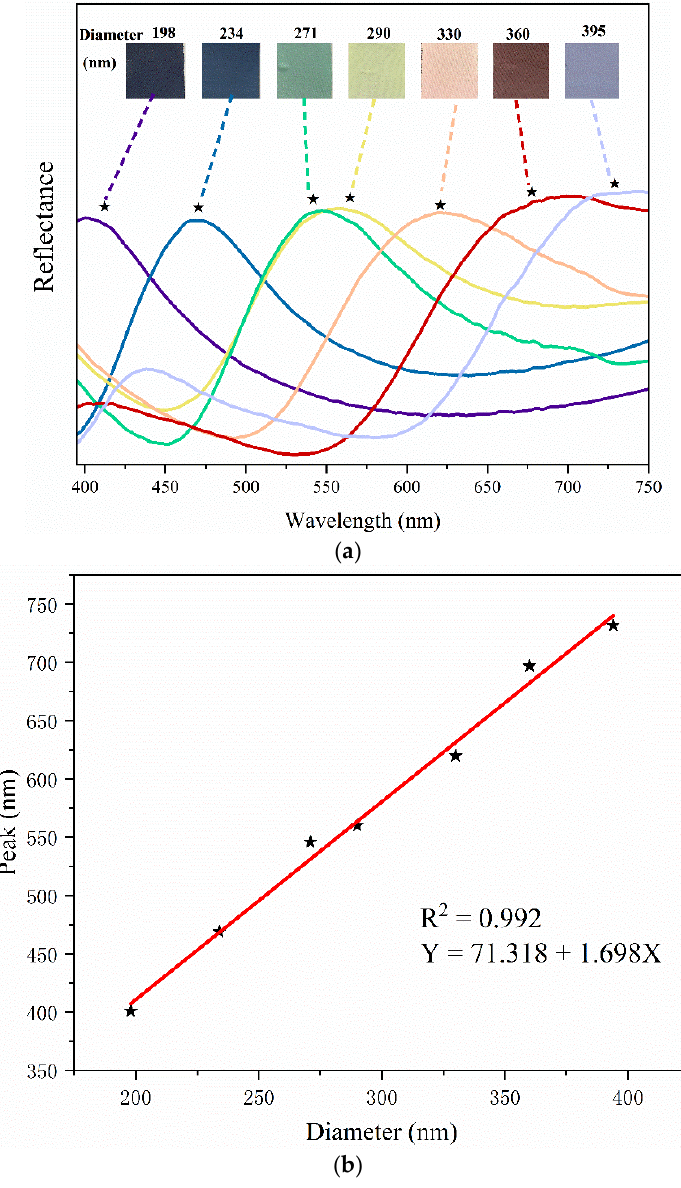
Figure 5. ( a ) Structural color and reflection spectrum of SiO 2 @PDA photonic crystal on silk. ( b ) Fitting of particle size and peak wavelength.